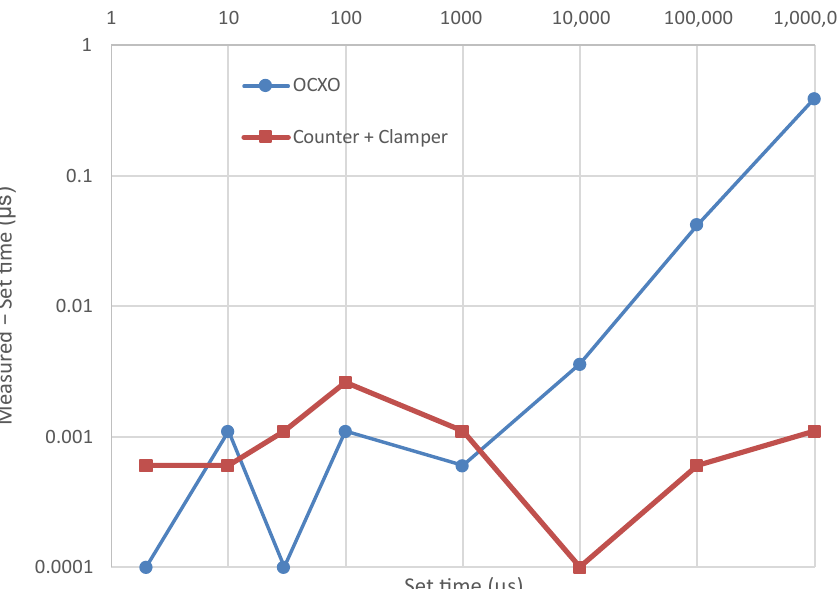
Figure 4. Time delay measurement results.